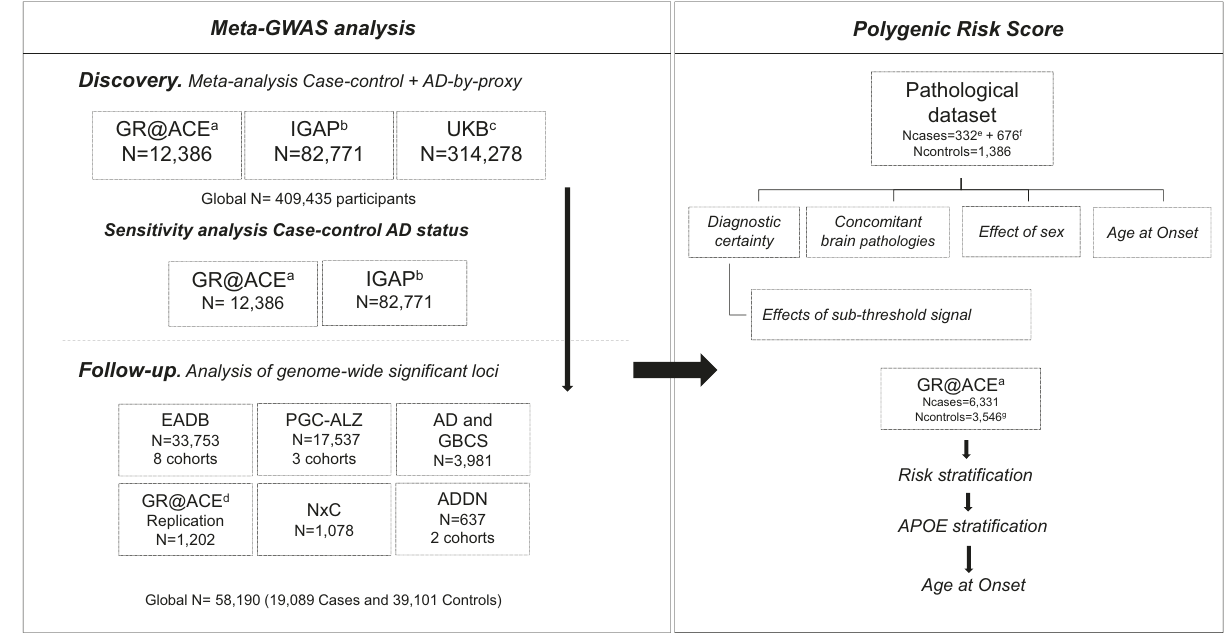
Fig. 1 Flow chart of analysis steps. Discovery meta-analysis in GR@ACE, IGAP stage 1 + 2 and UKBiobank followed by a replication in 16 independent cohorts. The genome-wide signi fi cant signals found in meta-GWAS were used to perform a Polygenic Risk Score in a clinical and pathological AD dataset. See Supplementary Methods to more information about the cohorts included and methods to the PRS generation. a Extended dataset (Moreno-Grau et al. 19 ), b StageI + StageII (Kunkle et al. 20 ), c By proxy AD: Meta-analysis of maternal and paternal history of dementia (Marioni et al. 21 ), d Extra and independent GR@ACE dataset incorporated only for replication purposes, e Pathologically con fi rmed AD cases, f AD cases diagnosed based on clinical criteria, g Controls participants aged 55 years and younger. N = Total of individuals within speci fi ed